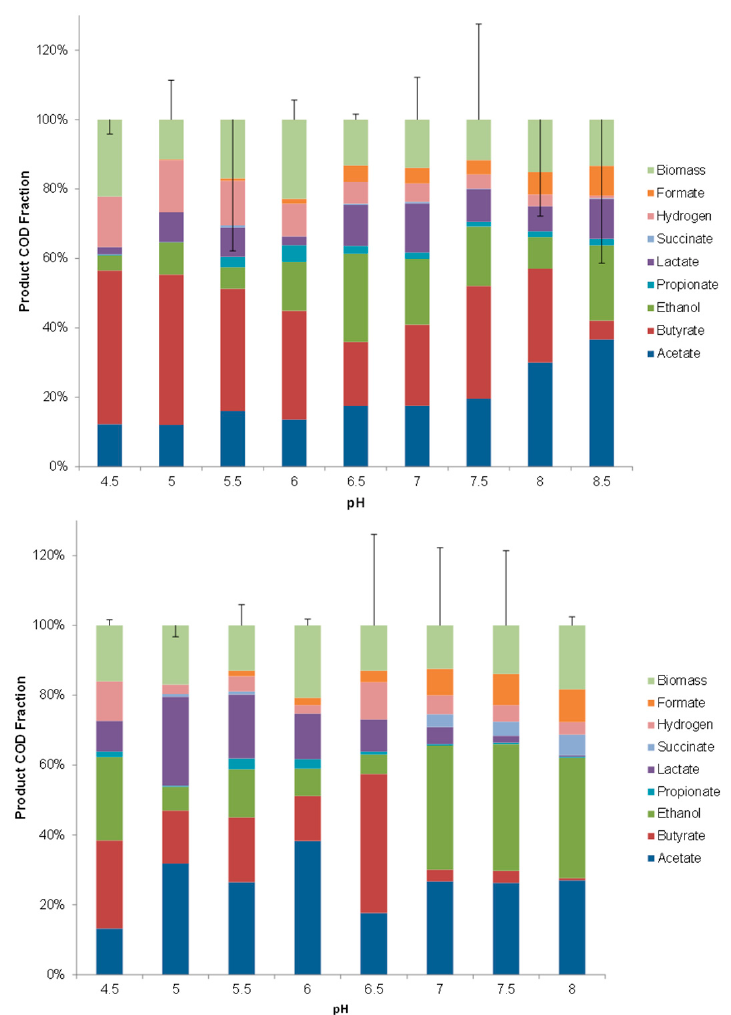
Figure 2. Influence of different pH regulation approach to product spectrums of glucose (in % produce) fermentation in progressive pH approach (top) and reset pH approach (bottom). Error bars are 95% confidence intervals based on two-tailed t -tests ( n = 5).